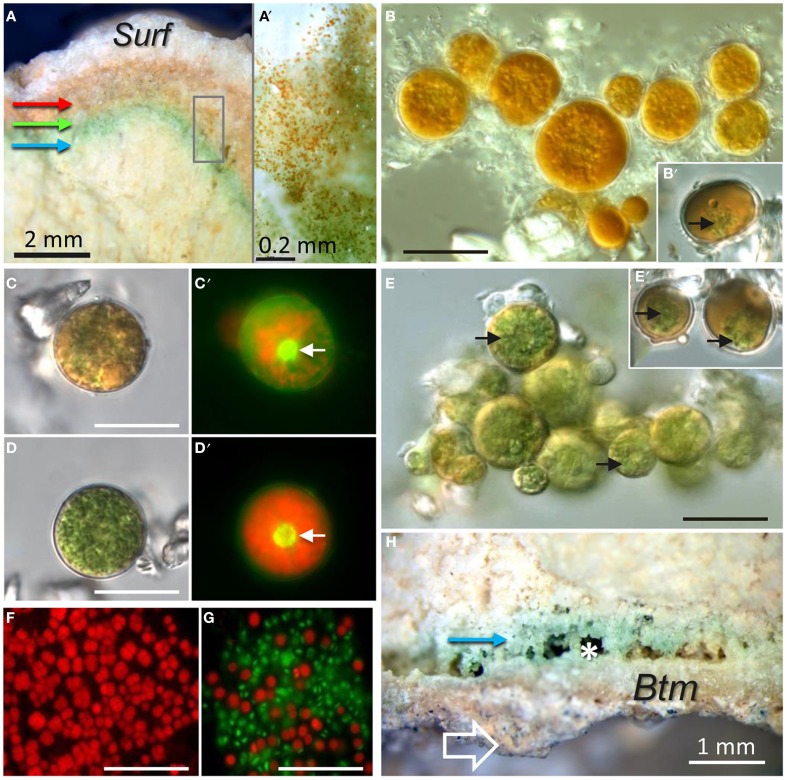
Cross-sections of gypsum layered microbial endolithic colonization. (A) Stereoscopic microscopy view with details in (A′) of the orange-to-green cryptoendolithic colonization layer close to the gypsum dense surface (Surf); red, green, and blue arrows point to orange algae, green algae, and cyanobacteria colonization zones respectively. (B) DIC image of orange mature algae and (B′) DIC image insert where some relicts of loose chloroplasts within the mature alga can be distinguish. (C) DIC and (C′) FM image of orange algae with dispersed chloroplasts [red signal in (C′)] surrounding the alga nucleus [arrow in (C′)]. (D,E) DIC images and (D′) FM image of green algal cells with uniformly distributed dense chloroplasts in the whole cytoplasm [red signal in (D′); arrow in (D′) point to nucleus and arrow in (E) point to chloroplasts; (E′) DIC image of green cells in the first step of the carotenogenesis process with less dense chloroplasts (arrows). (F) MF image of cryptoendolithic cyanobacteria with red autofluorescence signal. (G) FM image of hypoendolithic cyanobacteria; autofluorescence red signal that potentially belong to vital cells and green signal corresponding to cells with degraded photosynthetic pigments. (H) Stereoscopic microscopy view of hypoendolithic cyanobacteria colonization zone (blue arrow) within gypsum close to the bottom (arrow) of the rock. Note the dense structure of the bottom (Btm) layer and small cave-shaped pores in the hypoendolithic habitat (asterisk). Scale bars = 20 μm, except (A,A′,H).